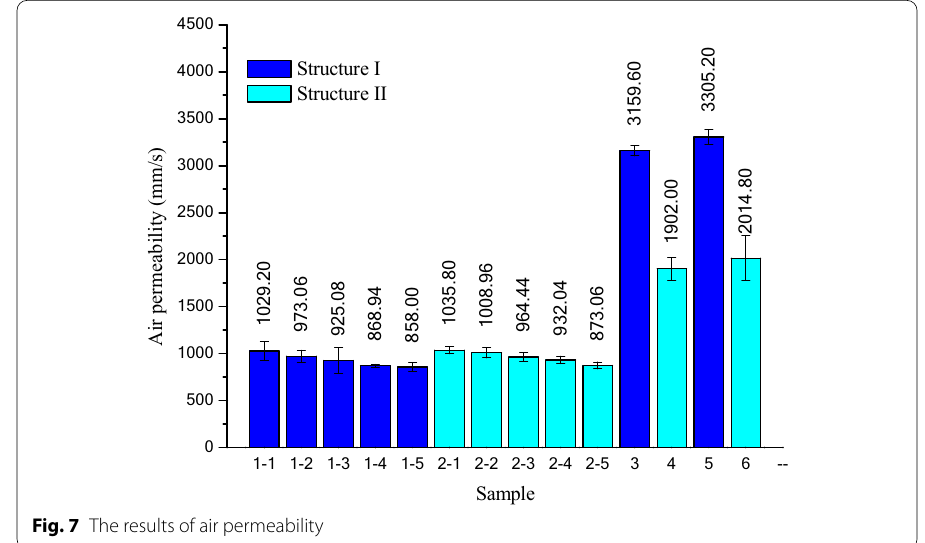
Fig. 7 The results of air permeability